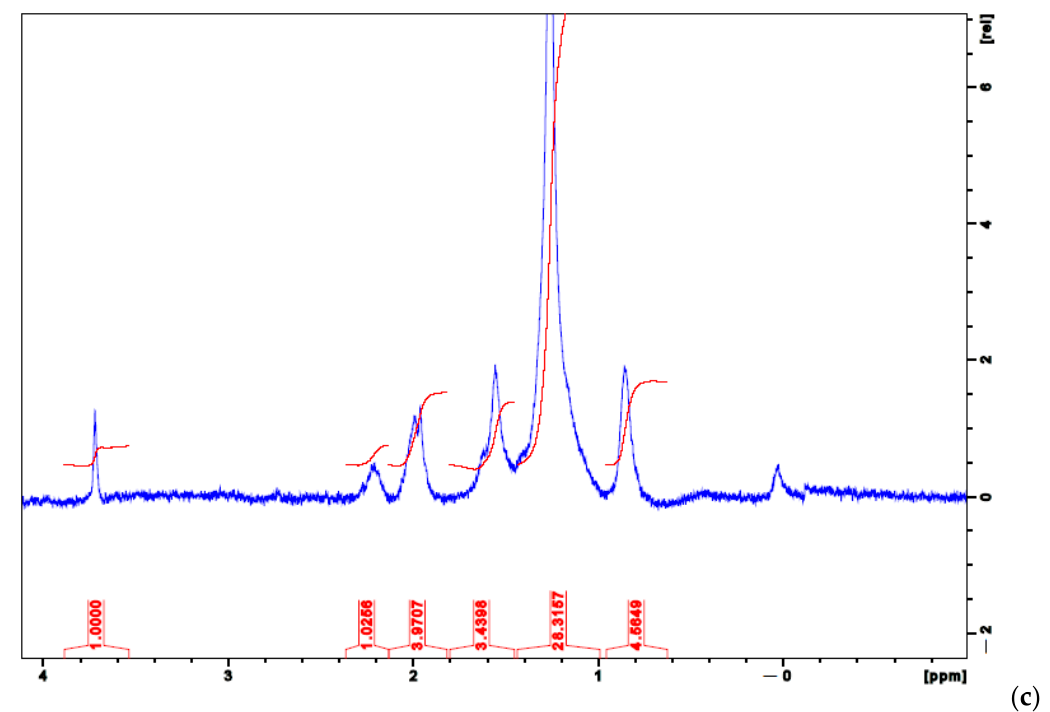
Figure 5. Nuclear magnetic resonance (NMR) results for ( a ) 20%, ( b ) 40%, and ( c ) 60% HA integration within the SA hydrogels.